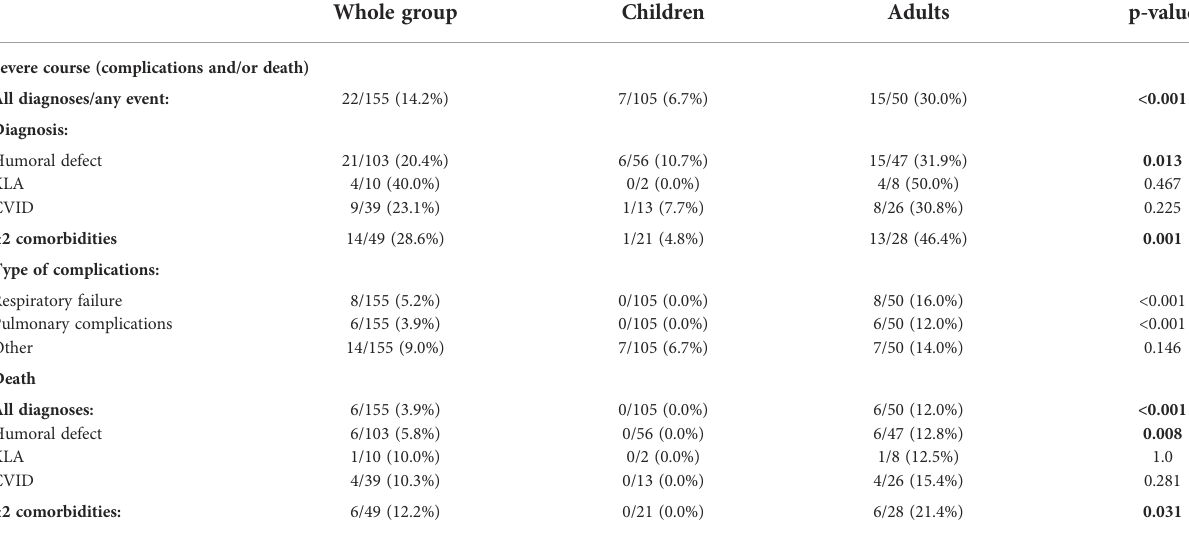
TABLE 4 Analysis of complications and deaths depending on selected diagnoses and